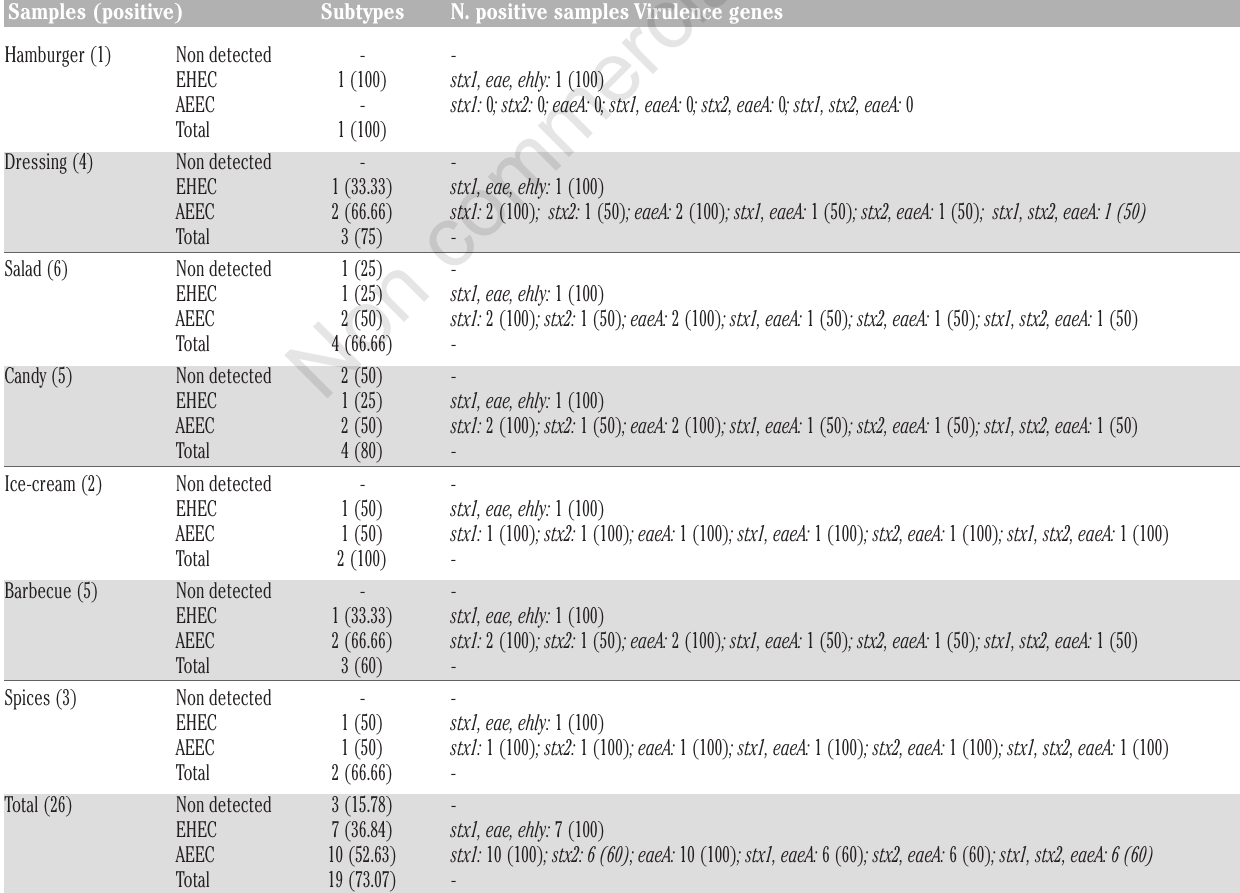
Table 3. Distribution of virulence factors and subtypes in the Escherichia coli strains isolated from ready to eat food samples. Samples